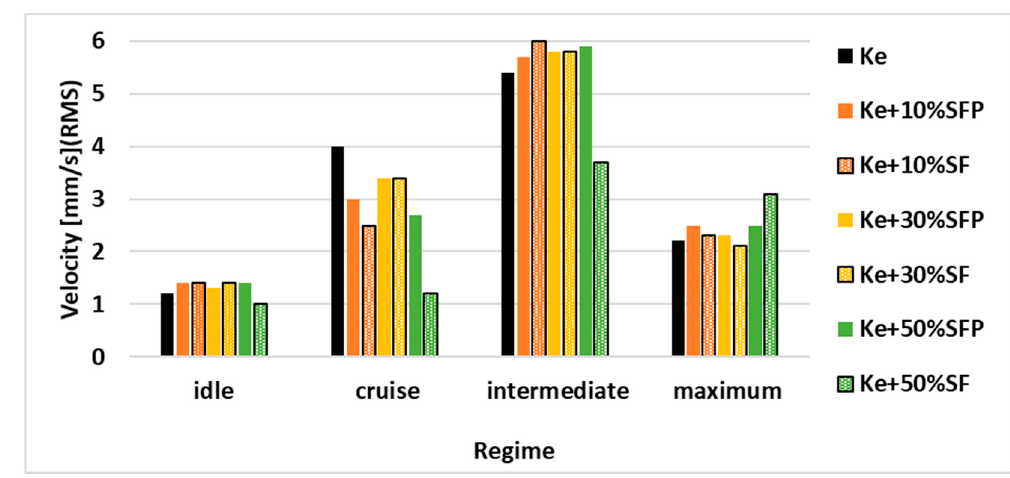
Figure 11. Axial vibration levels.